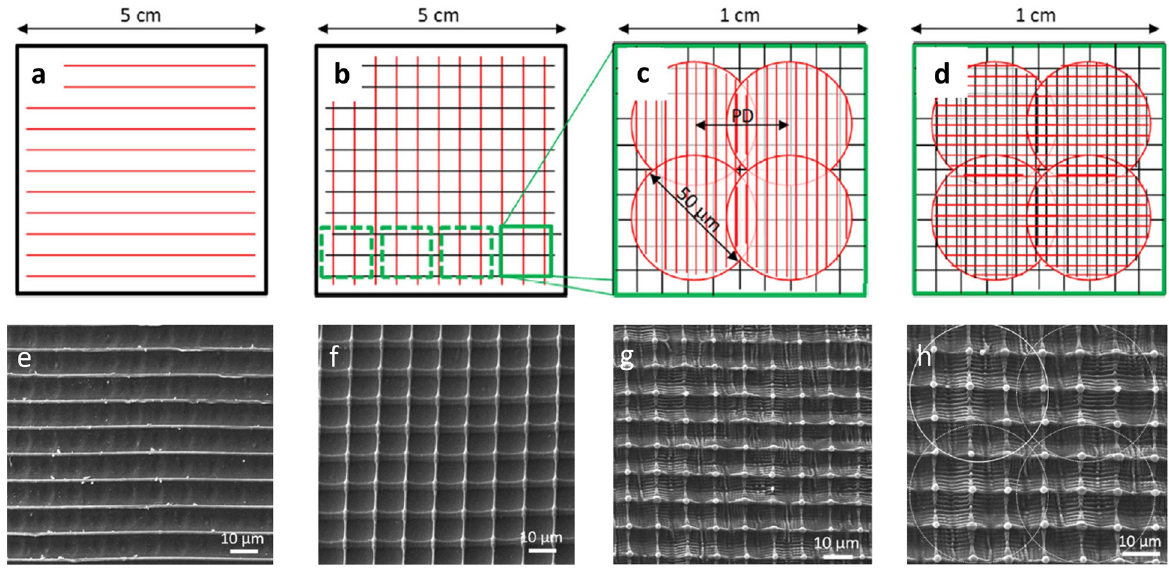
Figure 5: (a) – (d) Process steps for fabricating first the PET structures (the circles in white dotted lines in d indicate the size of each laser spot and the overlap between them. (e) – (h) SEM images of the structured PET each image corresponds to the process step indicated in each diagram immediately above in the top row. Figures reproduced from ref. [86] (© 2016 WILEY-VCH Verlag GmbH & Co.